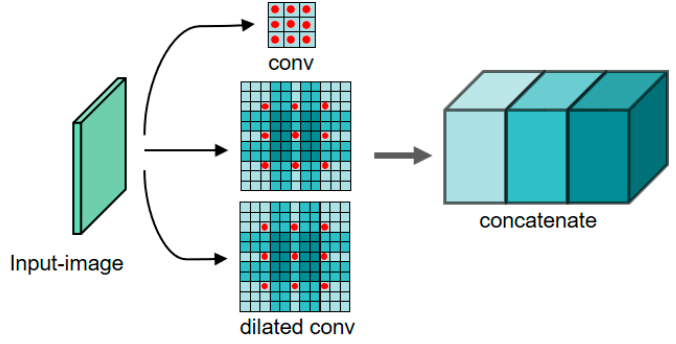
Figure 5. Dilated convolution guidance structure.